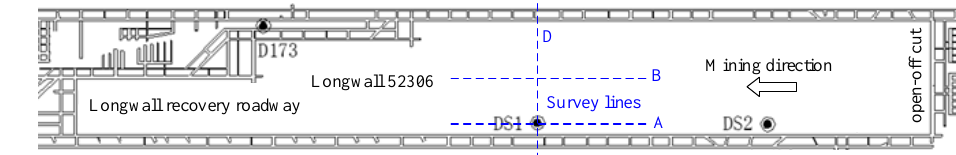
Figure 1. Layout of the roadways and surface subsidence survey lines for longwall 52306.